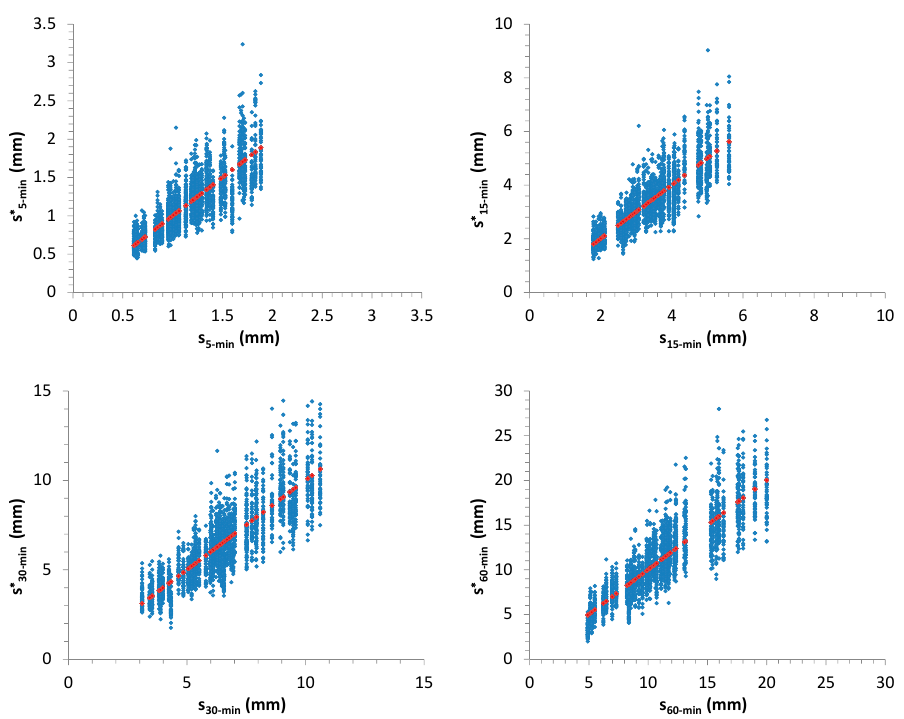
Figure 15. Scatter plots showing the relationship among starting values for sample standard deviation, s, related to 50 AMR series (horizontal axis) and their associated distribution (indicated with the superscript * and reported on vertical axis). The red dots indicate the 1:1 line.